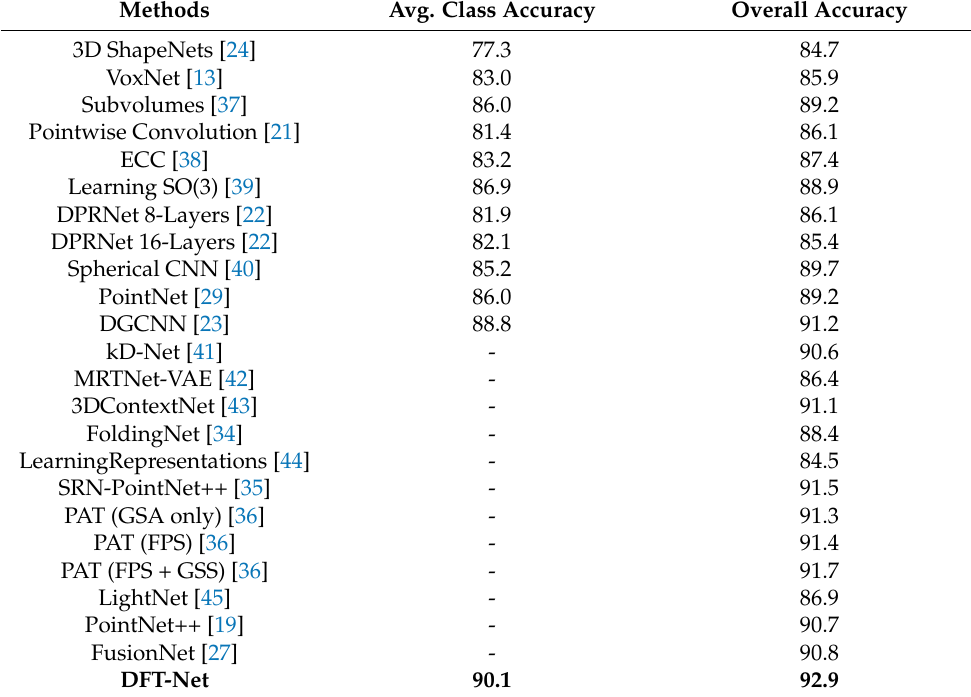
Table 1. Overall and average-class accuracies achieved on ModelNet40 dataset.